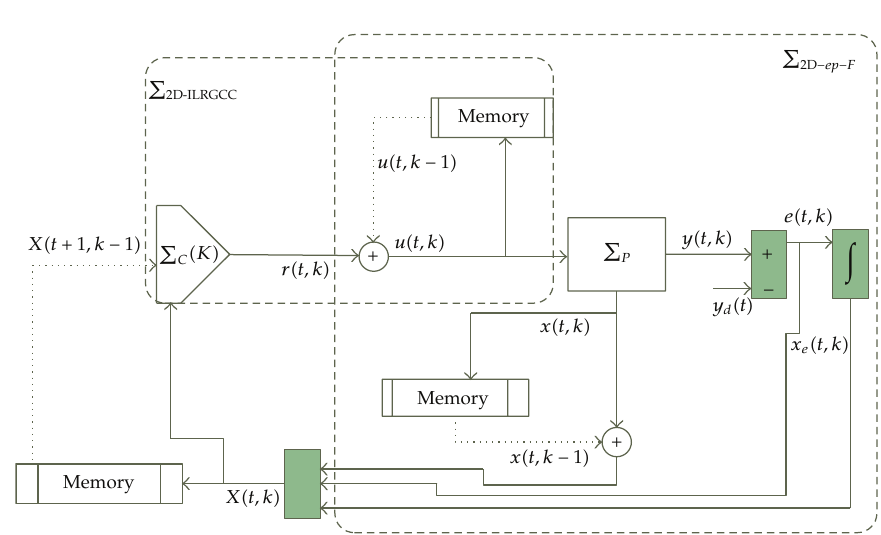
Figure 1: Schematic diagram of the structure of a closed-loop